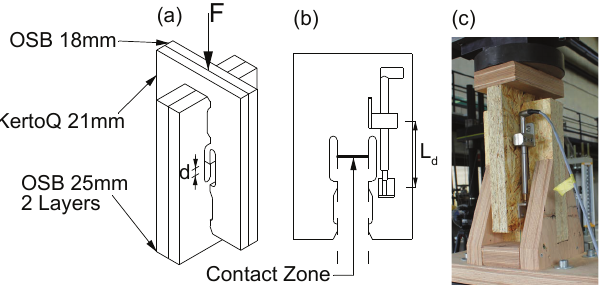
Figure 5. ( a ) Axonometry of the experimental setup for TT joints. ( b ) Side view. ( c ) Photo of the experimental setup with LVDTs.